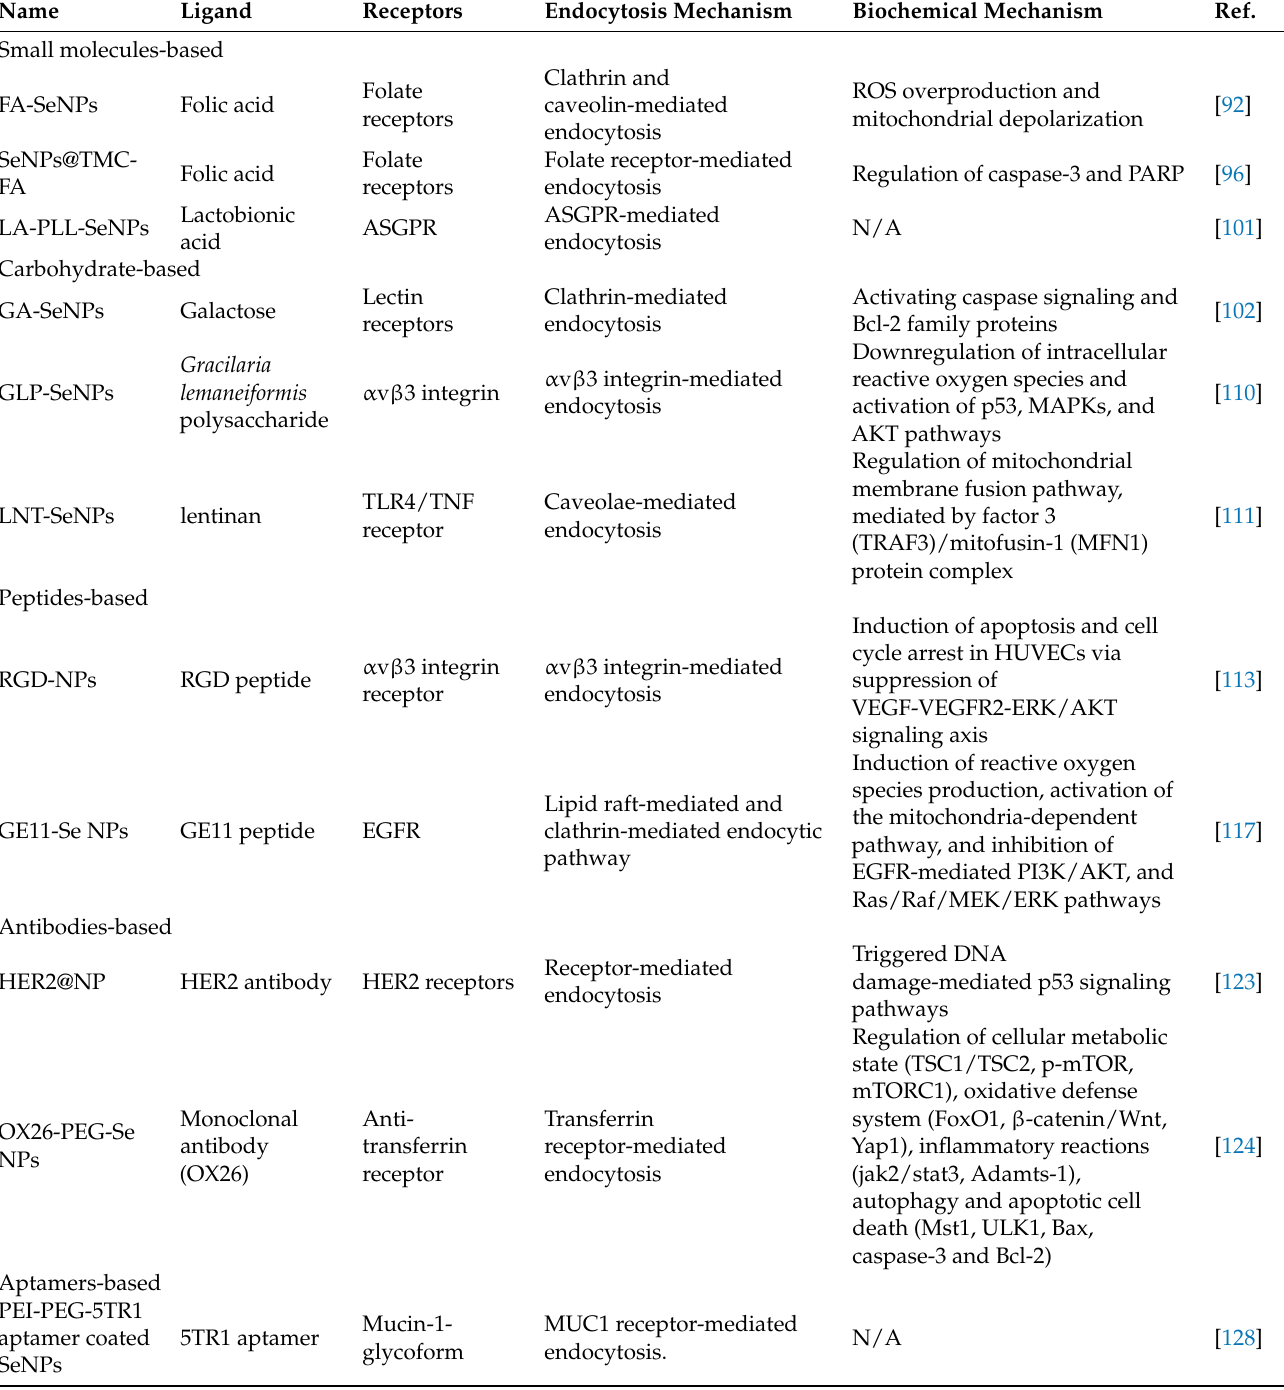
Table 2. Various ligand conjugated SeNPs with different endocytosis and their potential biochemical